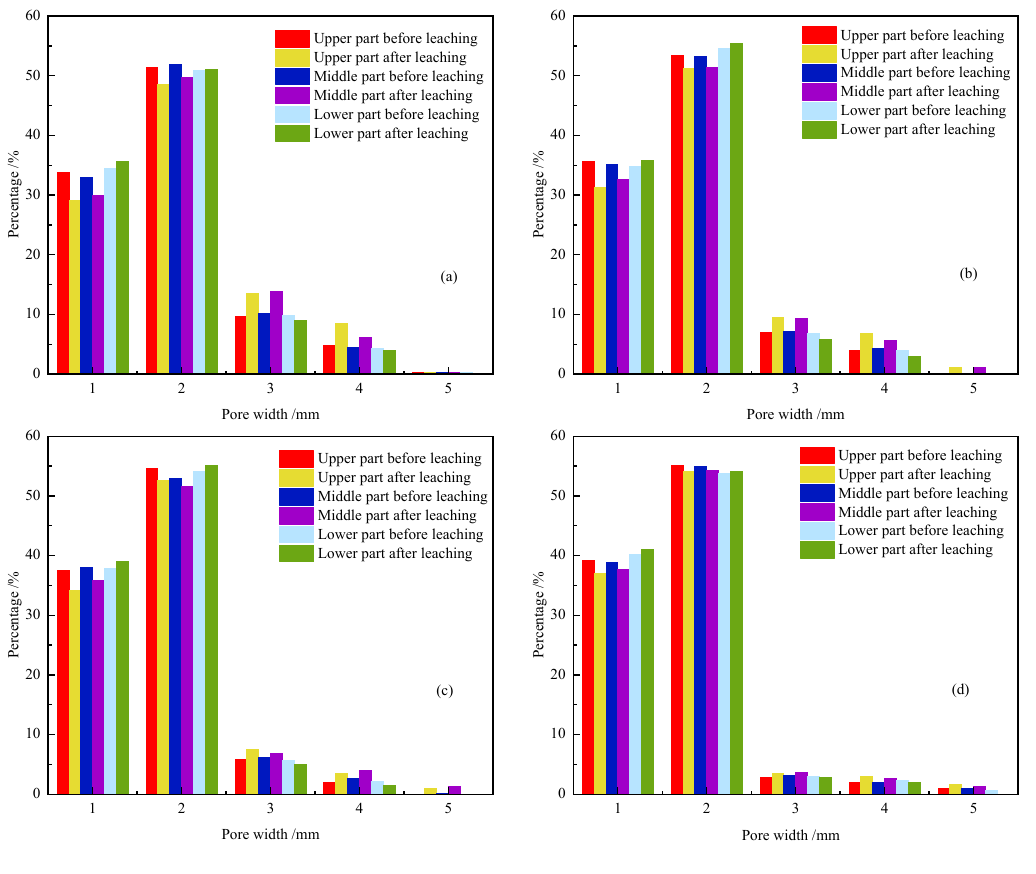
Figure 10. The variation rules of the pore width of four kinds of ore samples with different depths. ( a ) A D=2.03 ; ( b ) B D=2.23 ; ( c ) C D=2.43 ; ( d ) D D=2.63 .